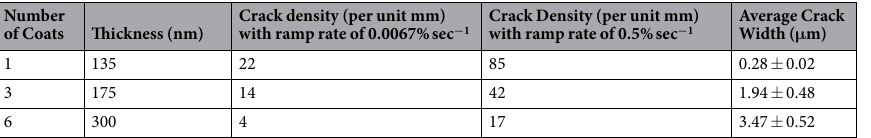
Table 1. Comparison of crack density and average crack width for 1, 3 and 6-coat rGO-PDMS films upon 5% of applied strain.